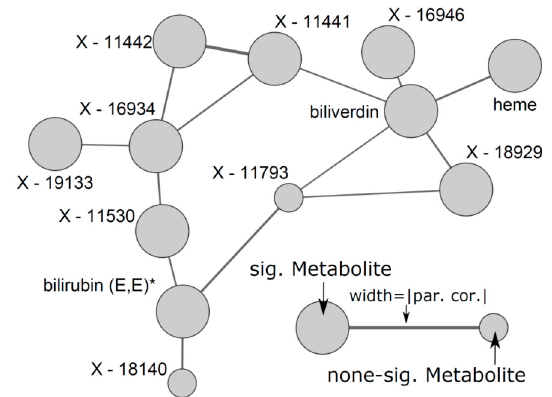
Figure 4. Subnetwork from the Gaussian graphical model to reconstruct metabolite dependencies with a particular focus on heme related metabolites. Increased node size indicates significant associations with at least one red blood cell count trait under investigation. par. cor. = partial correlation.